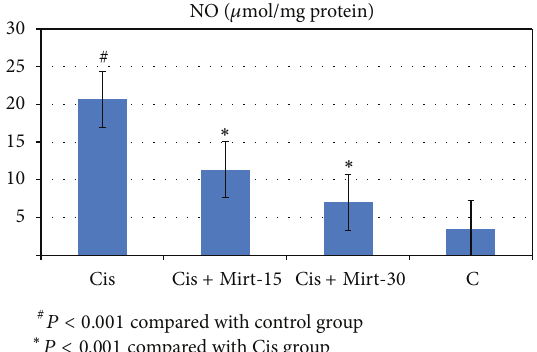
Figure 3: NO levels of study groups.